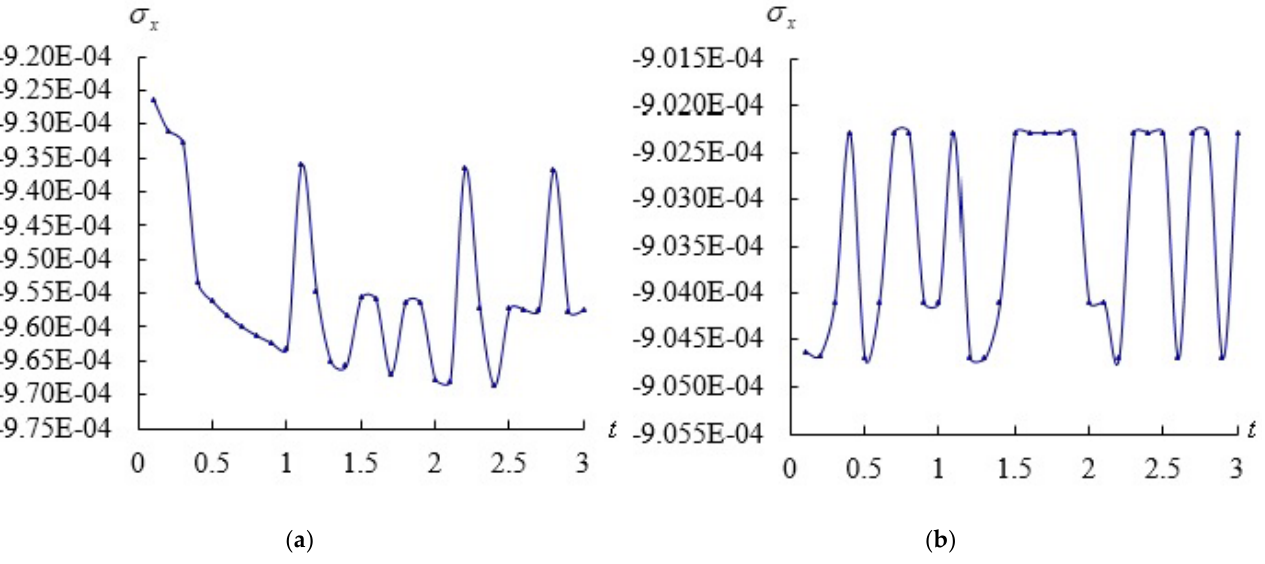
( b ) Figure 4. . Figure 5. .